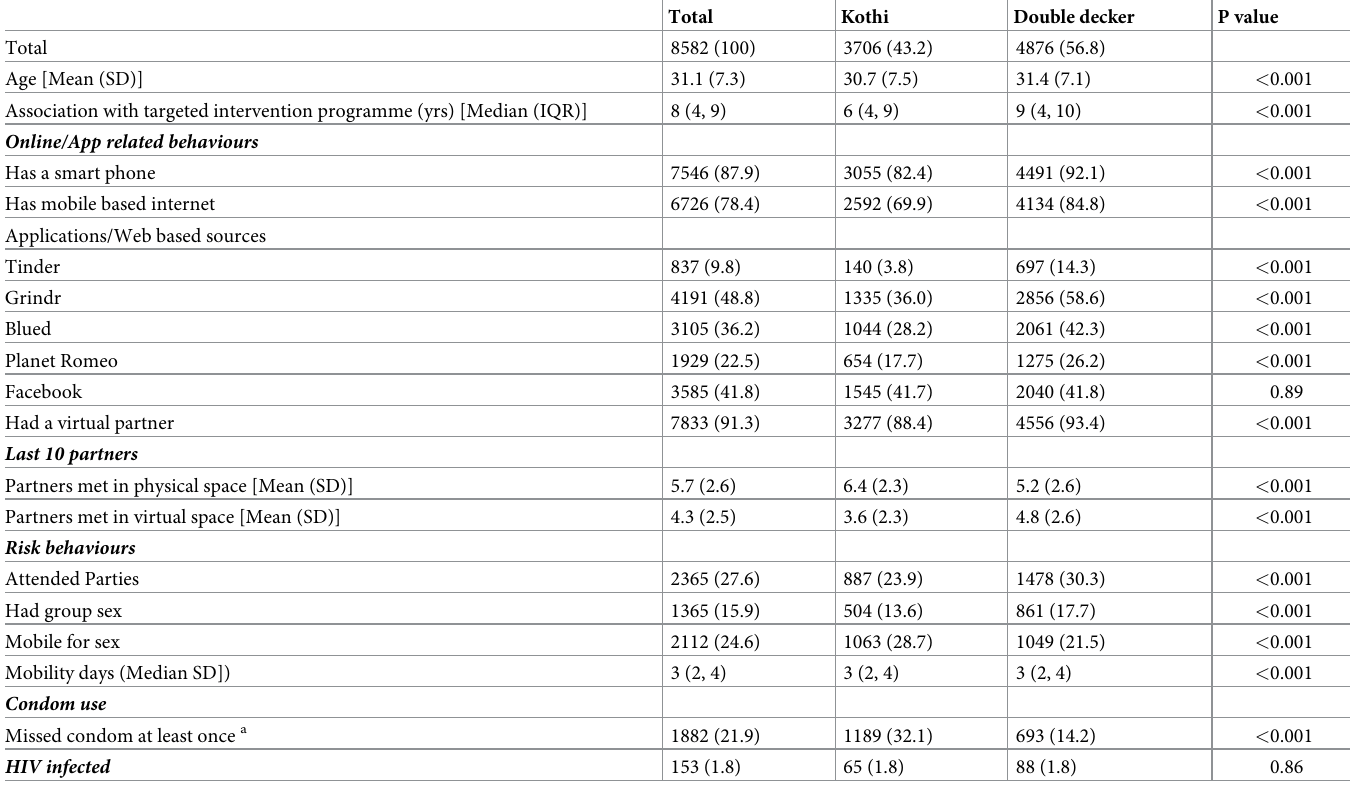
Table 2. Table comparing the demographics, internet practices, and high-risk behaviours of among different types of MSM in Mumbai,